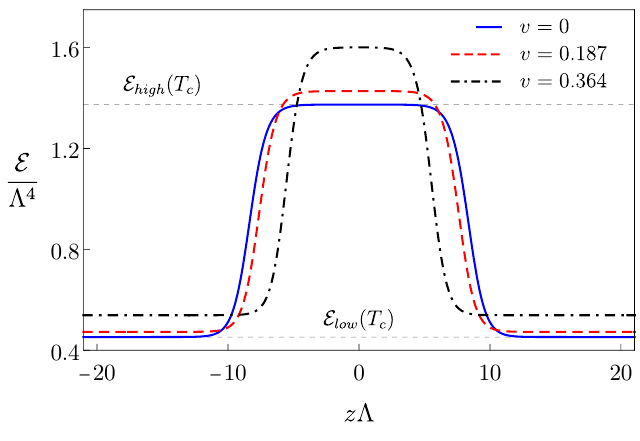
Figure 6 . Steady-state energy profiles of domains with different velocities. The total energy in the box is the same in all cases. The average energy is ¯ E / Λ 4 = 0 . 817 and the box has size L Λ = 42 . 0719